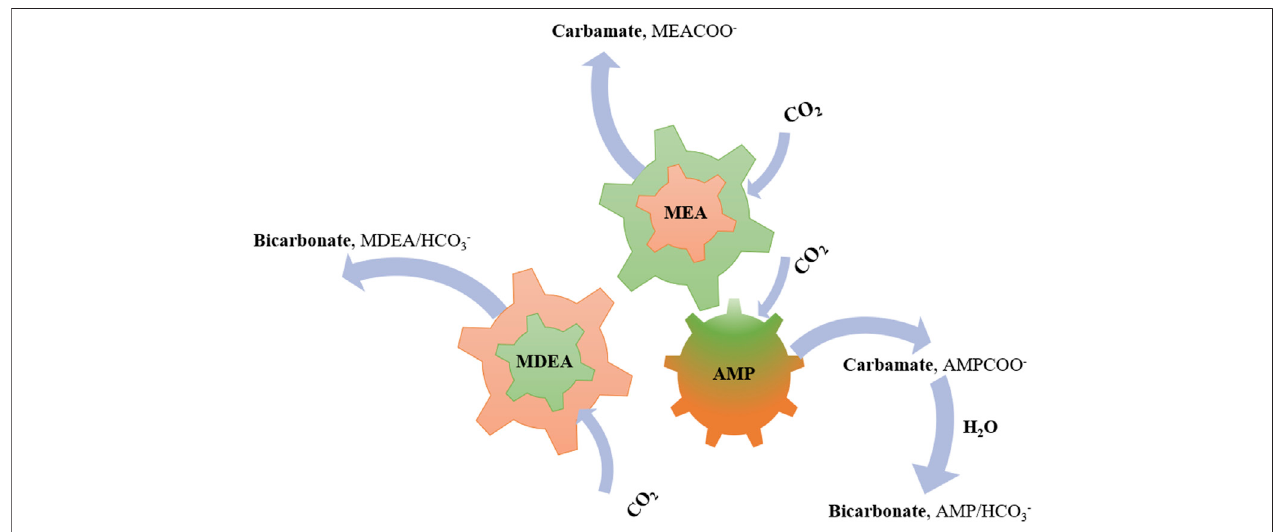
FIGURE 3 | Typical reaction pathways of MEA, MDEA and AMP aqueous amine solutions.